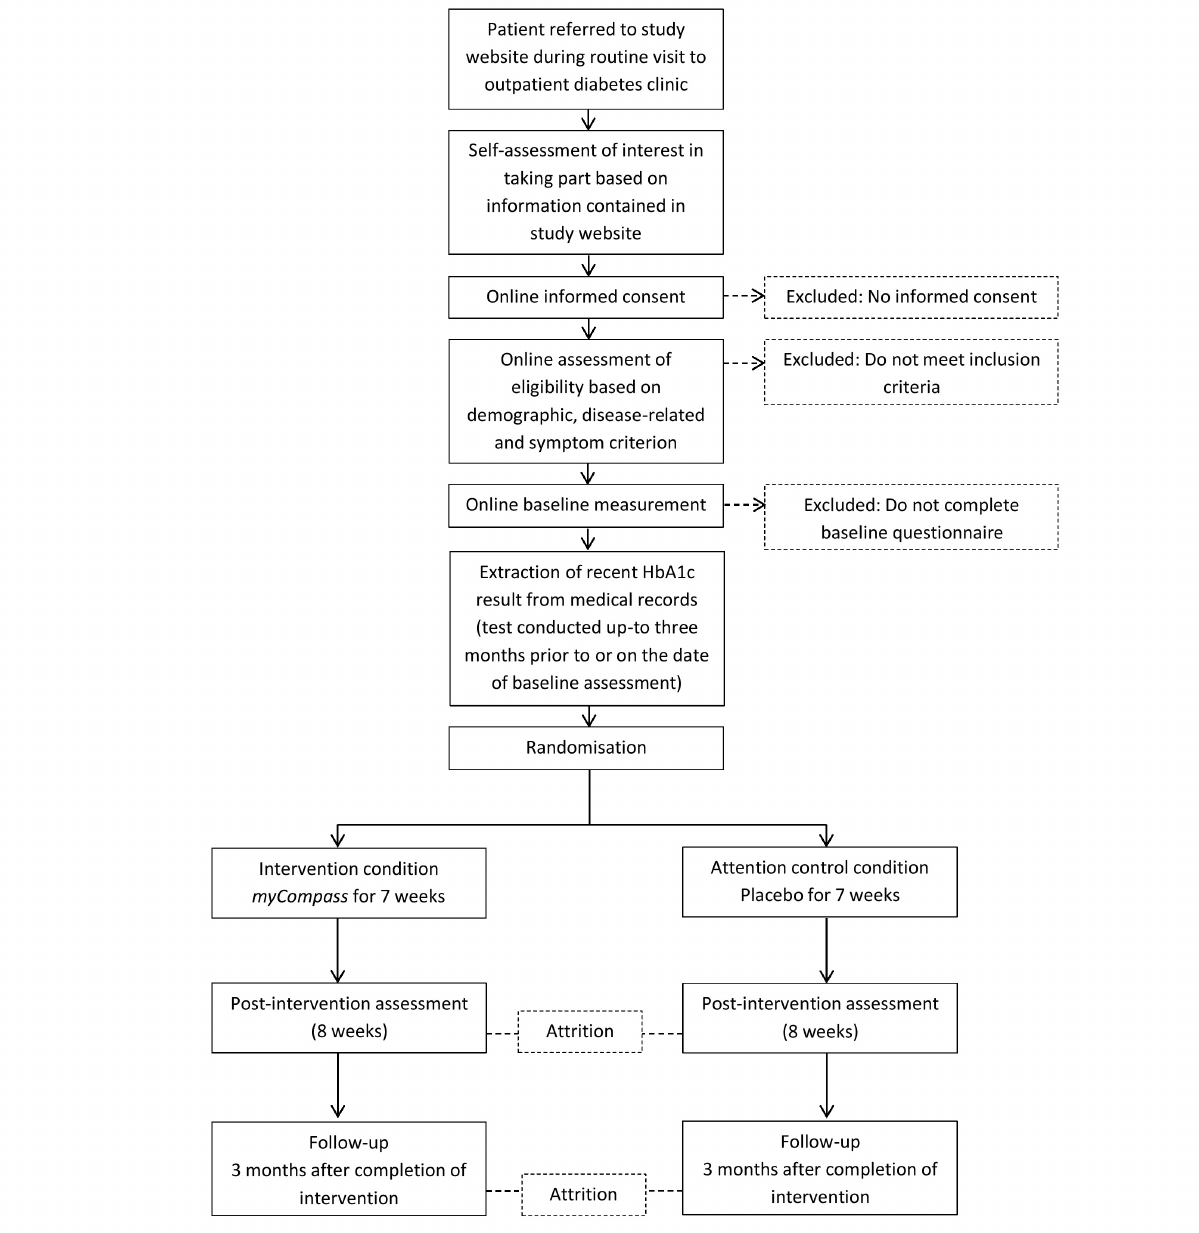
Figure 1. Study flow